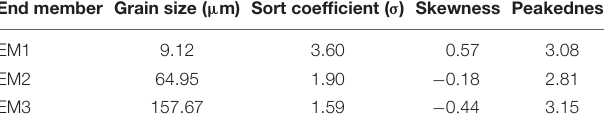
Studies of sediments on core ODP 882A in Detroit